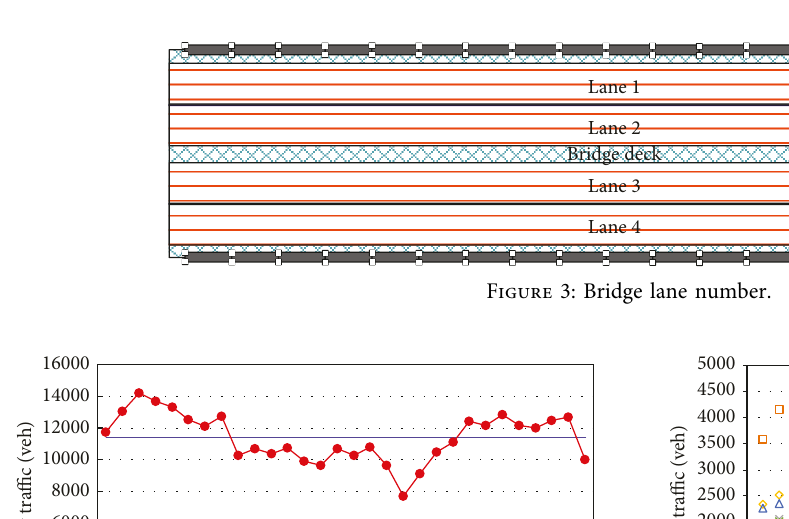
Figure 2: Bridge elevation structure drawing (unit: cm).